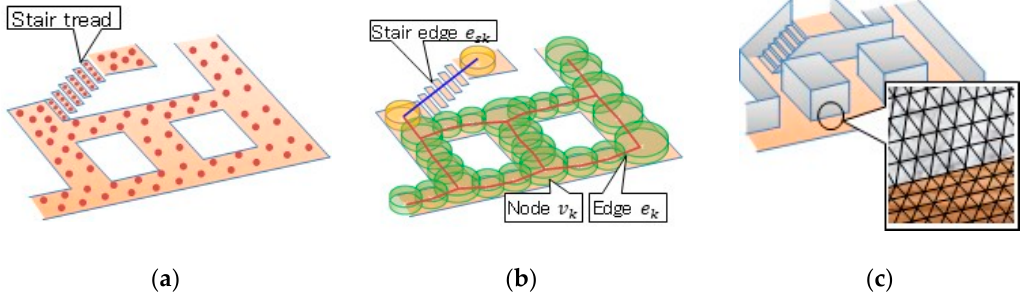
Figure 2. 3D as-is environment model: ( a ) Walk surface points W S ; ( b ) navigation graph G N ; ( c ) textured environmental geometry G I